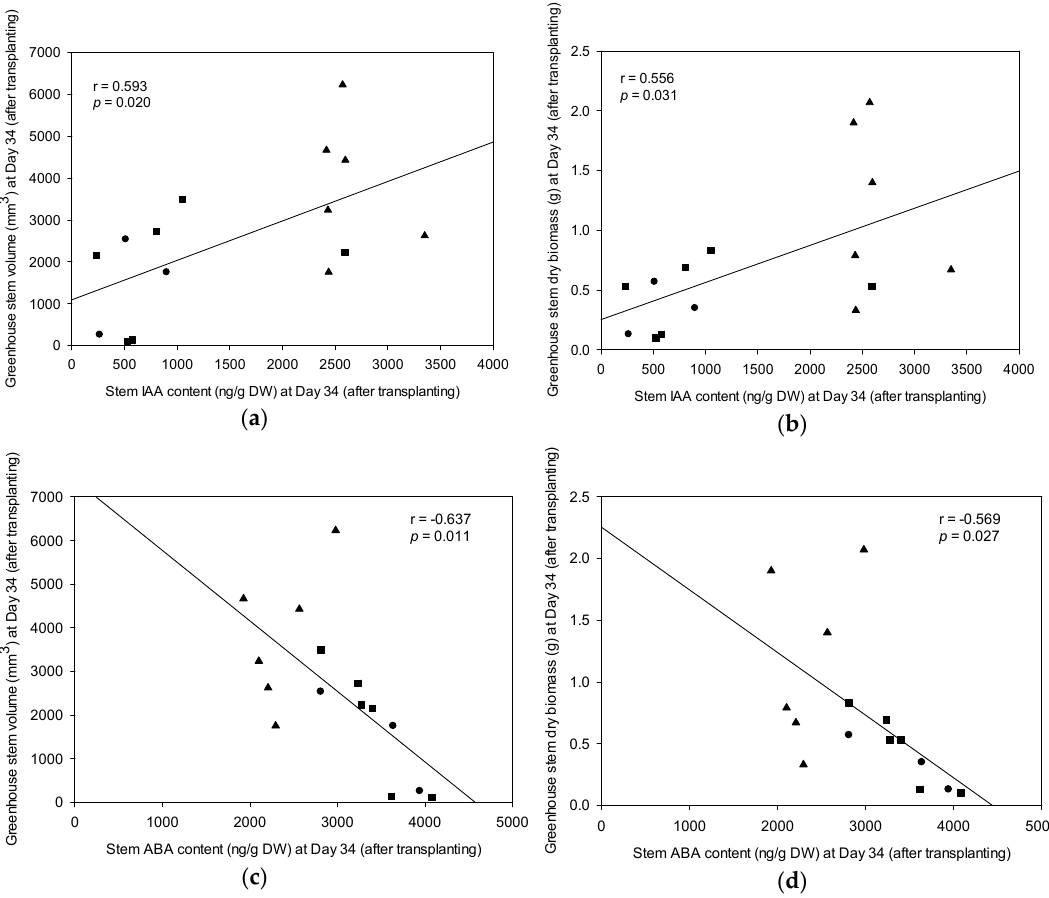
Figure 6. Pearson’s correlations (r) of tissue concentrations of indole-3-acetic acid (IAA) and abscisic acid (ABA), versus stem dry biomass or stem volume of nursery-grown cuttings (new growth) at Day 34 (after transplanting). ( a ) New growth stem volume at Day 34 versus IAA in stem tissue at Day 34; ( b ) New growth stem dry biomass at Day 34 versus IAA in stem tissue at Day 34; ( c ) New growth stem volume at Day 34 versus ABA in stem tissue at Day 34; and ( d ) New growth stem dry biomass at Day 34 versus ABA in stem tissue at Day 34. Symbols represent individual progeny that had been previously grouped with FG ( ▲ ), SFG ( ■ ), and SG ( ● ). Note: SG = slow-growing progeny; SFG = slow-growing progeny from a fast-growing family; and FG = fast-growing progeny.